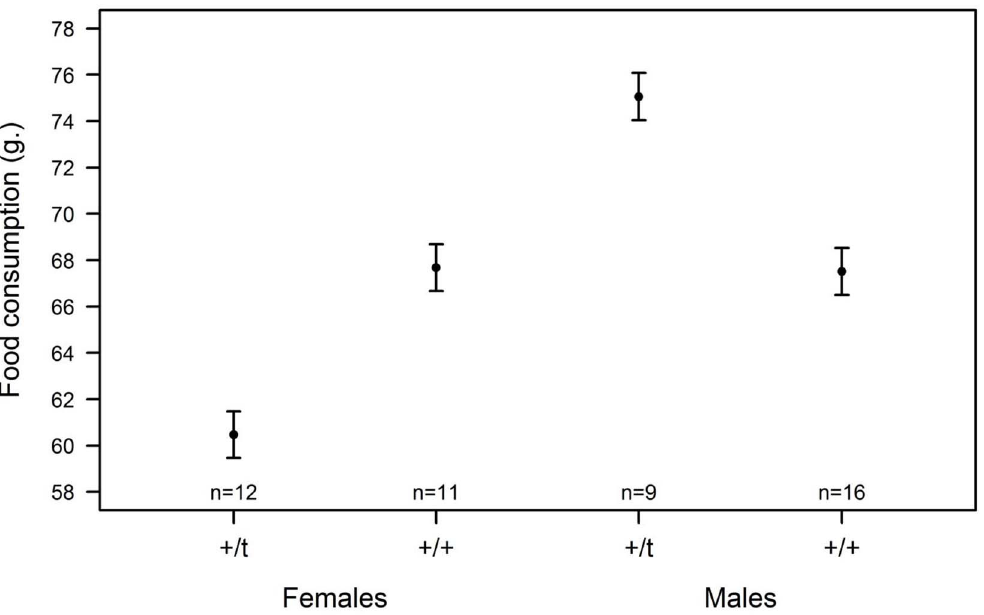
Figure 5. Influence of genetic background and sex on food consumption controlled for body weight (mean ± standard errors predicted by linear regression model).